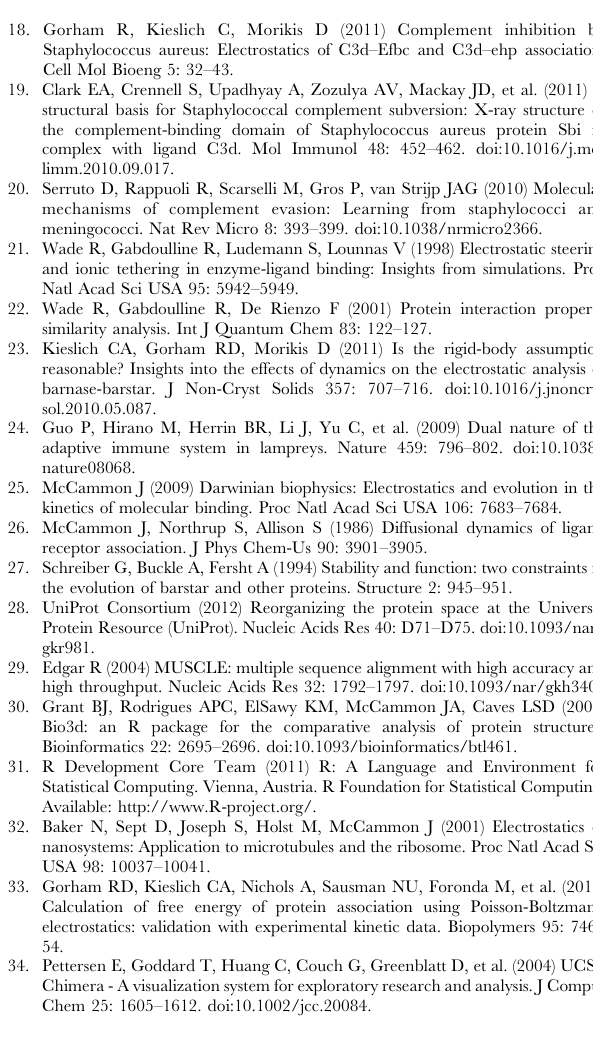
Figure S5 Sequence similarity clustering for the two sides of C3d. Dendrograms with distance matrix heatmaps illustrate clustering of the 24 C3d homologues based on percent identities within the two functional regions as defined by Supporting Figure 6: (A) CR2-face and (B) thioester-face. Net charge of each homologue is provided in parentheses. (TIFF) Figure S6 Multiple sequence alignment of 24 C3d homologues. A consensus sequence, as well as bars indicating conservation and charge variation per position, are included for comparison. The Clustal X coloring scheme (as implemented in UCSF Chimera), which is dependent on amino acid and conservation, was used to color the sequences. (TIF) Figure S7 Illustration of the two functional regions used for sequence analysis of complement C3d. Residues were assigned to the two regions according to their x-coordinates. The CR2-face (colored in red) includes residues that contain at least one atom with an x-coordinate # (mean(x) 2 5 A˚ ), while thioester face